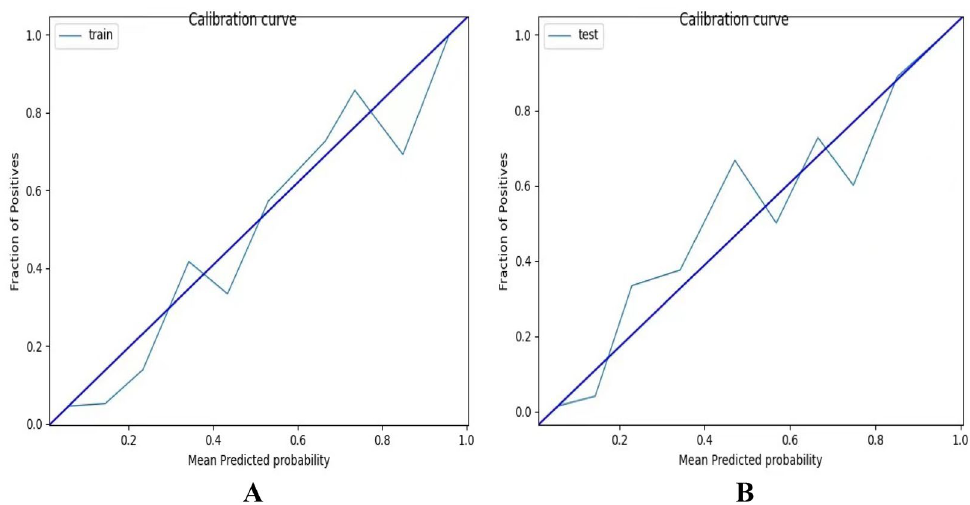
Figure 4. ( A ) Calibration curve of the nomogram in the training set. ( B ) Calibration curve of the nomogram in the validation